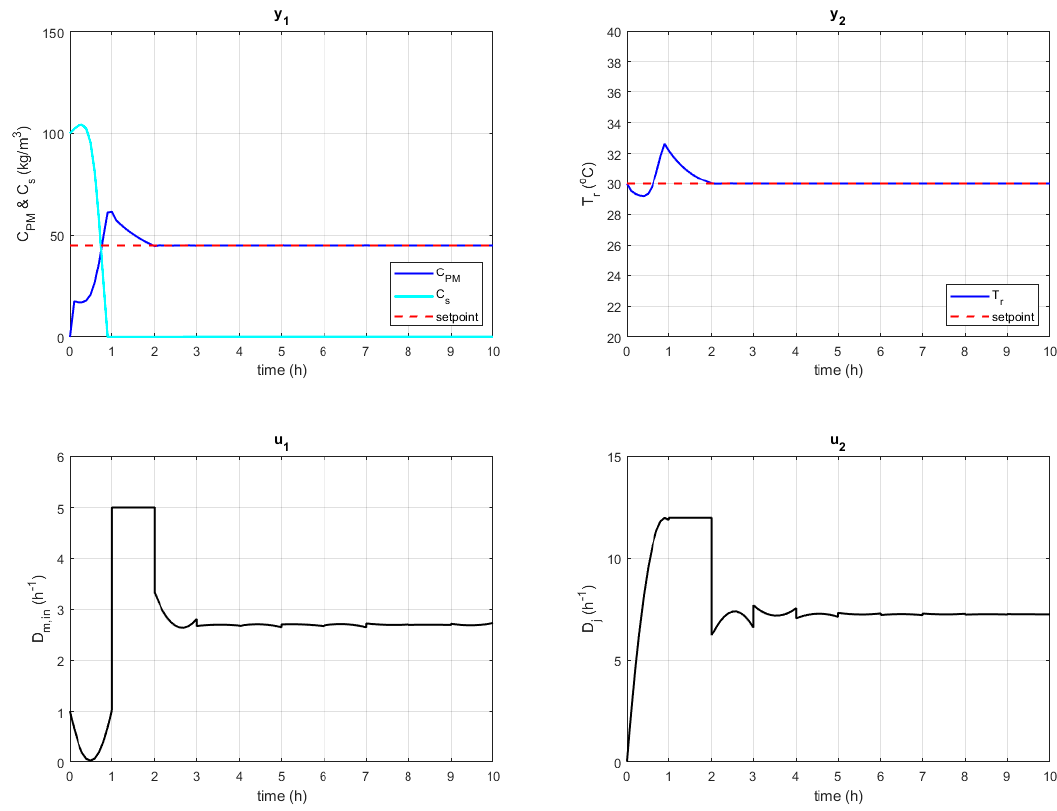
Figure 11. Case 2—closed-loop simulation without sustainability constraint: output (y 1 and y 2 ) and input (u 1 and u 2 ) profiles.